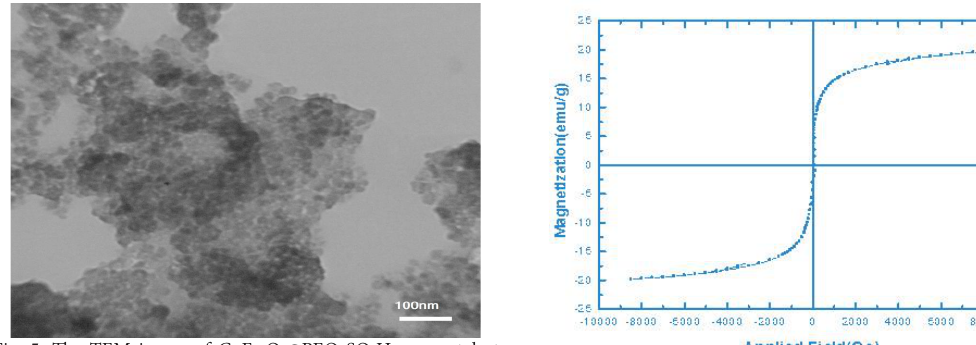
Fig. 5. The TEM image of CuFe